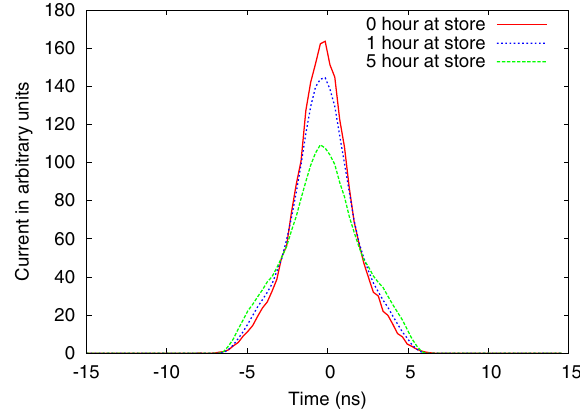
FIG. 18. Longitudinal bunch profiles at store from multiparticle simulation with 100 kV 197 MHz rf cavities. Momentum aperture 6 × 10 − 4 is 100 kV 197 MHz rf cavities which was used in 2013. The